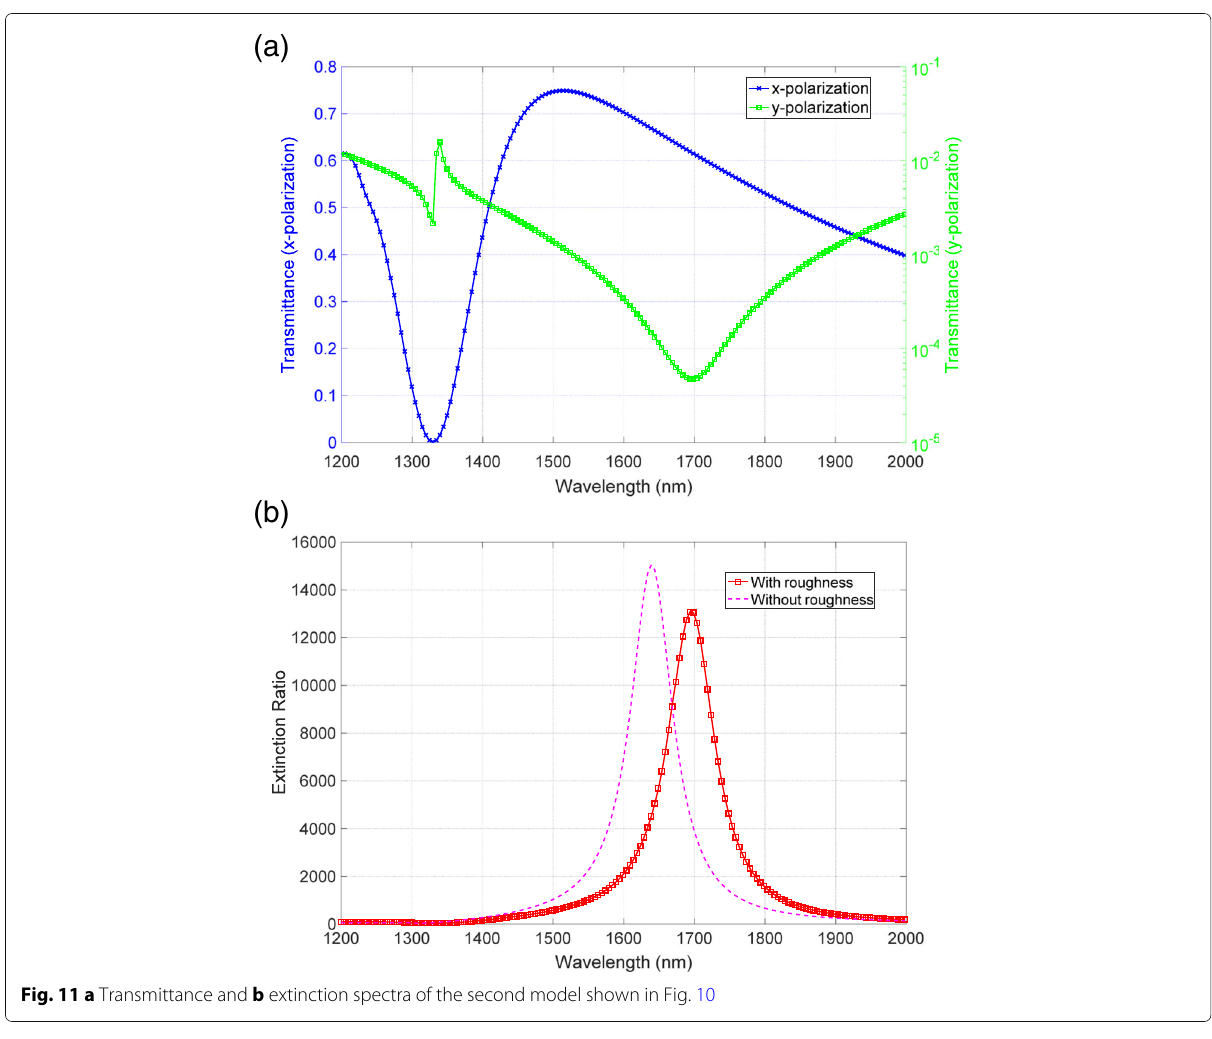
Fig. 11 a Transmittance and b extinction spectra of the second model shown in Fig. 10